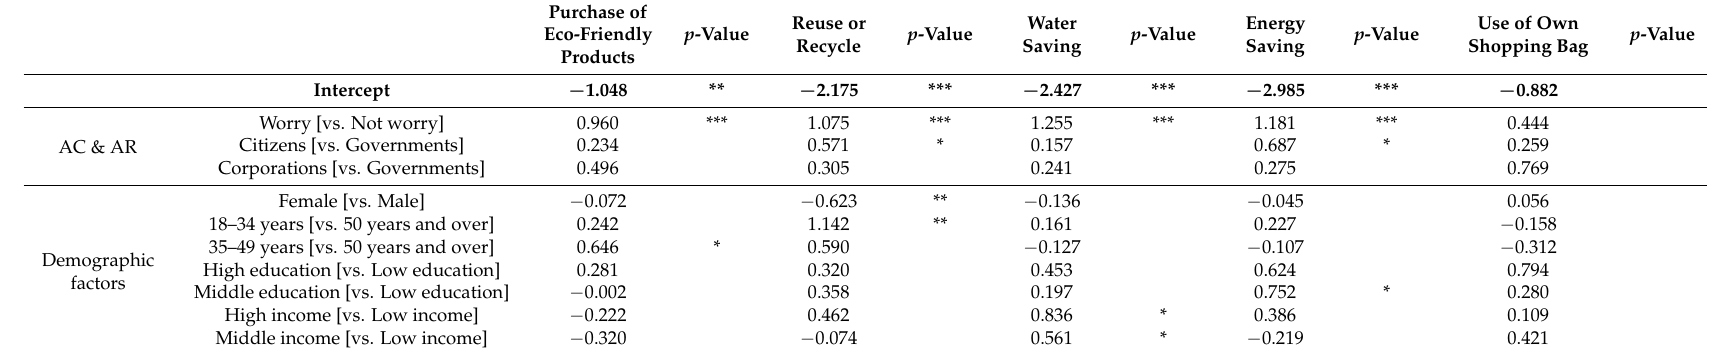
Table 3. Logistic regression analysis of causal effects of AC, AR, and demographic factors (coefficient β and p